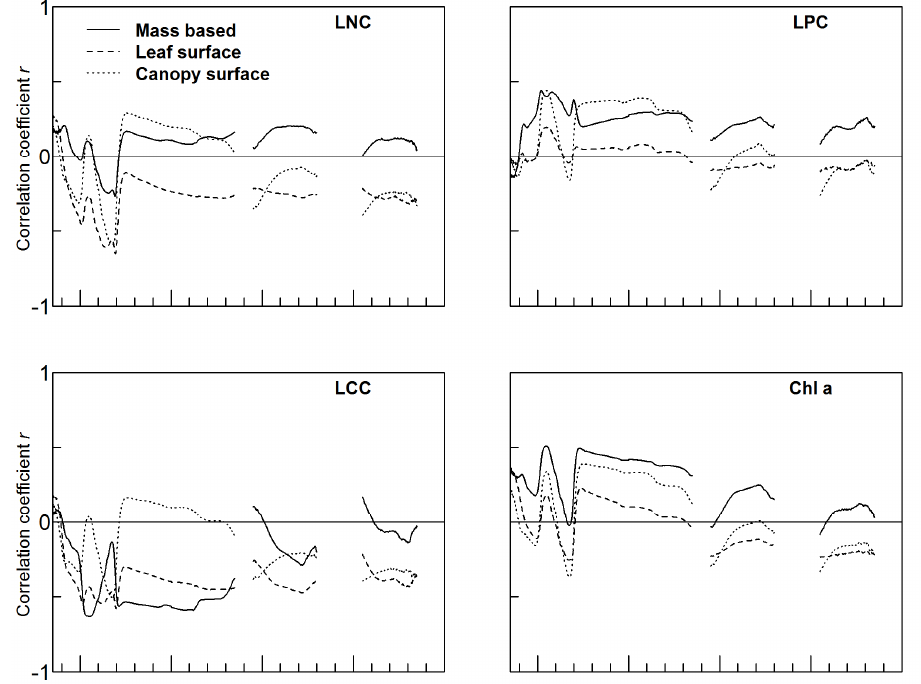
Figure 3. Pearson’s correlation coefficient between each spectral band and traits, each given in three different expressions of the trait value: mass based: mg·g − 1 dry matter, leaf surface: mg m − 2 leaf surface and canopy surface: mg m − 2 canopy